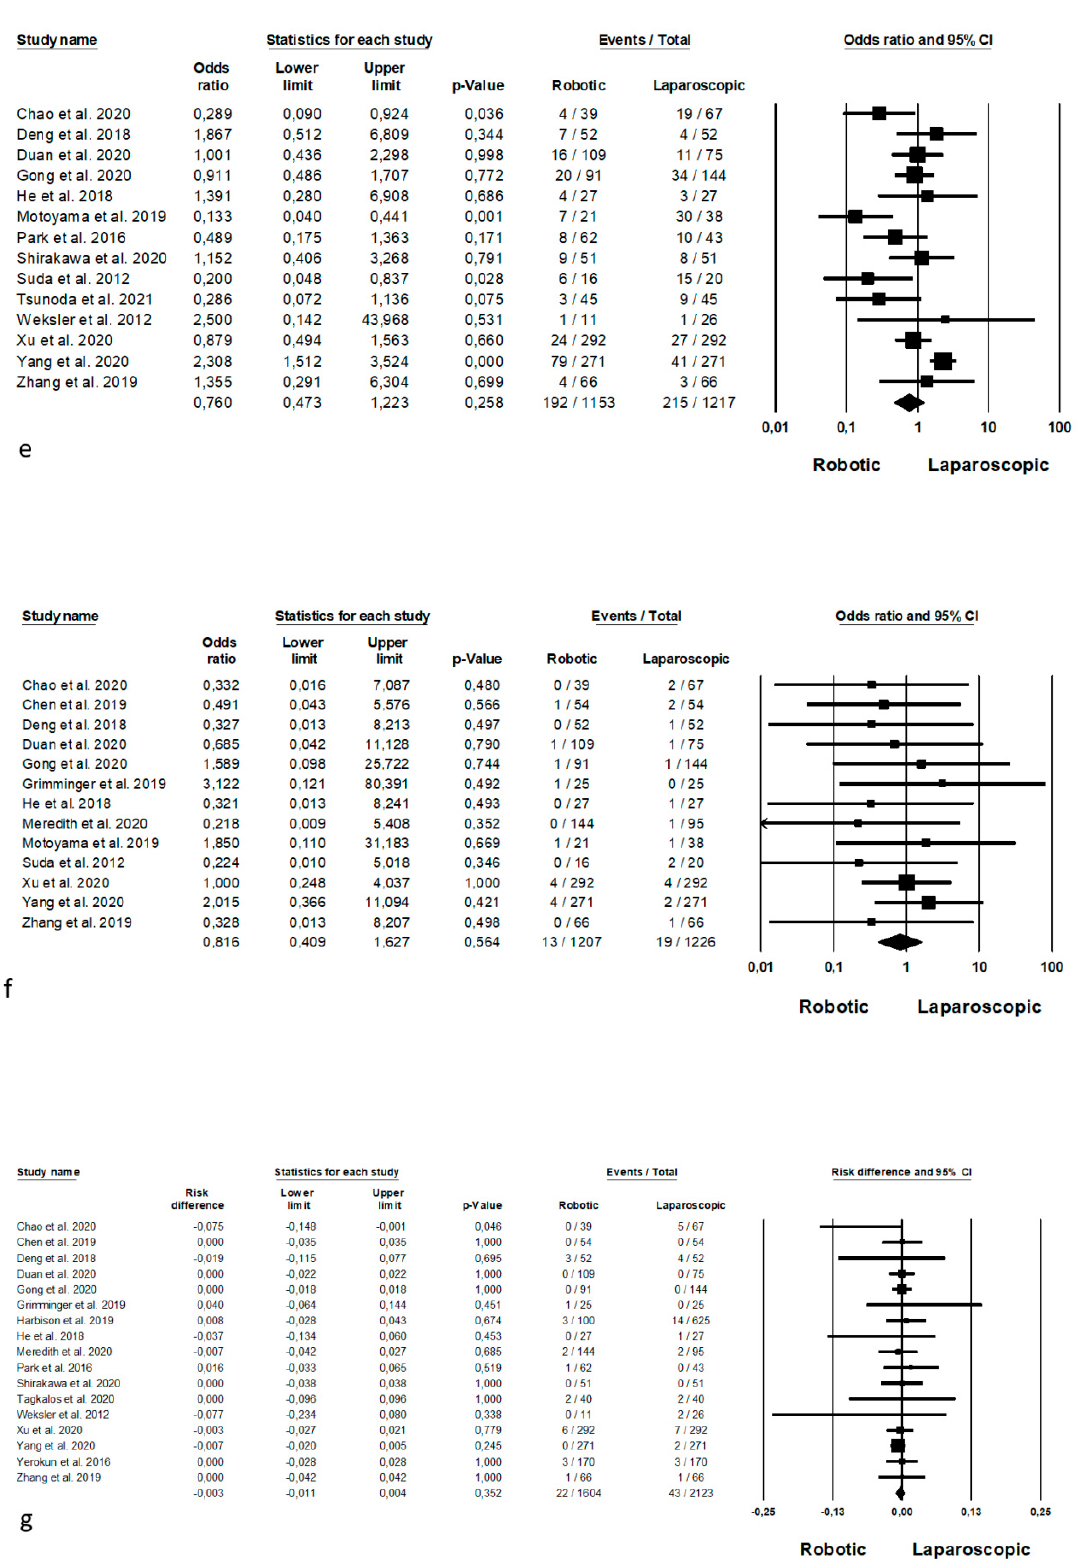
Figure 3. Robotic versus laparoscopic surgery: postoperative complications. ( a ) anastomotic leakage; ( b ) postoperative bleeding; ( c ) wound infection; ( d ) pneumonia; ( e ) RLN paralysis; ( f ) chylothorax; ( g ) mortality. RLN paralysis was reported by 14 Authors [23,29,32,33,37,38,40,42,45,48,50,51,53,57] on 2370 procedures (1153 robotic and 1217 laparoscopic), with no significant